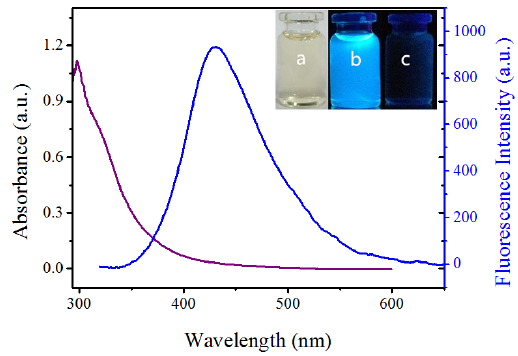
Figure 1. UV-vis absorption ( red ) and fluorescence emission ( blue ) spectra of the fluorescent carbon nanodots (FCNs).